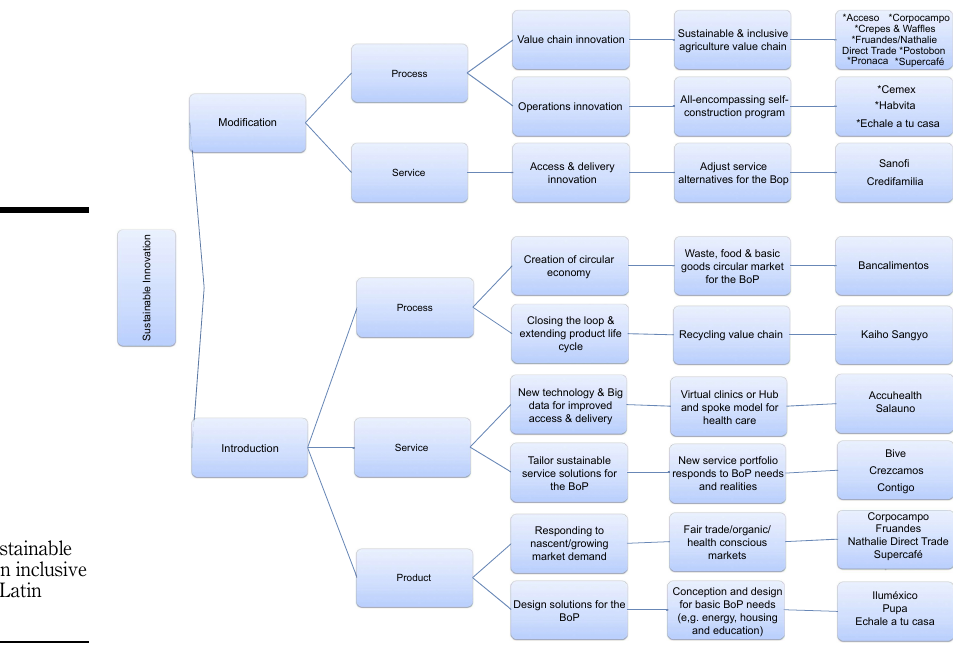
Figure 2. Types of